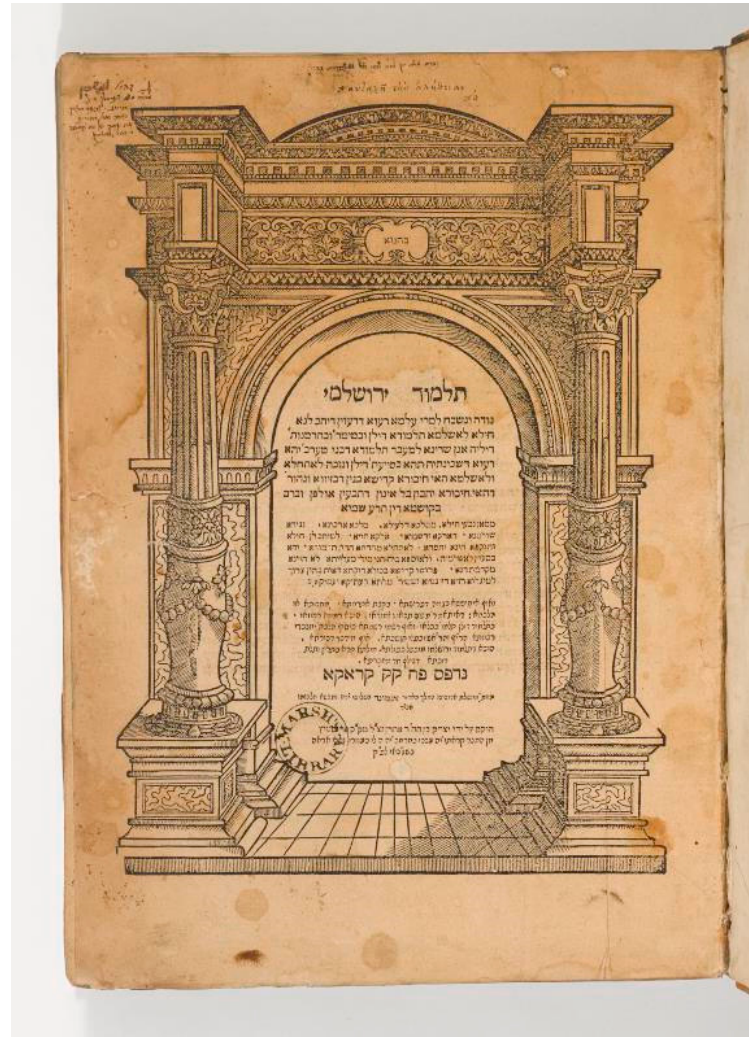
Figure 6. Talmud Yerushalmi; Marsh’s Library B.3.2.25.